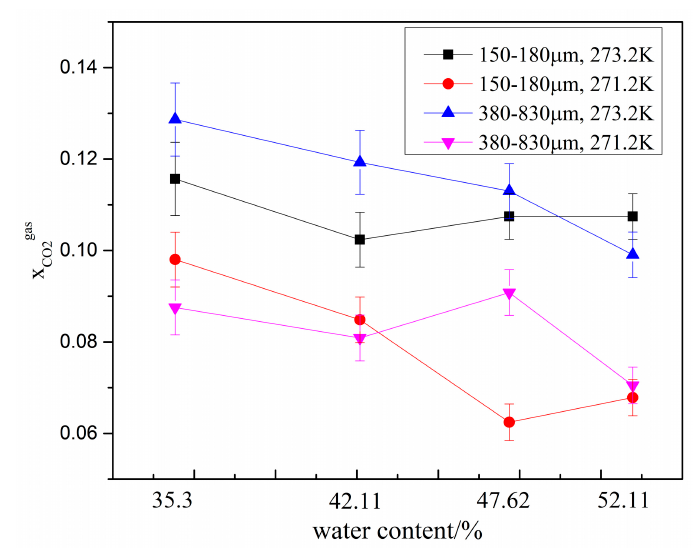
(cid:3034)(cid:3028)(cid:3046) ) in the presence of different ) in the presence of di ff erent (cid:3118) CO 2